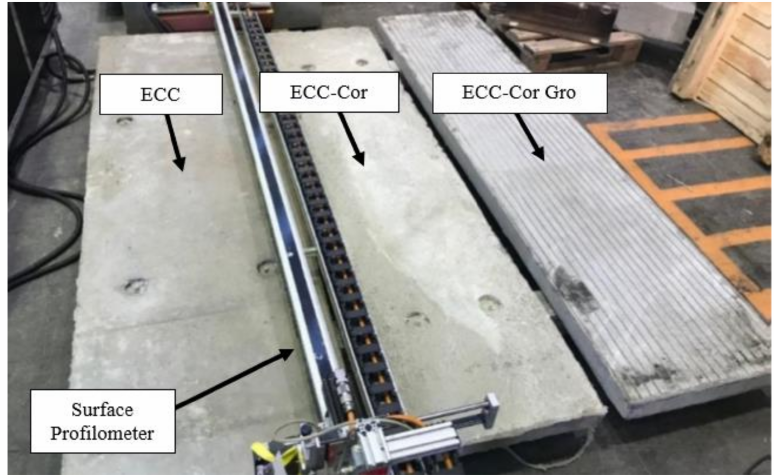
Figure 1. Specimen preparation for SHCC, modified SHCC-Cor, and SHCC-Cor-Gro (SHCC: strain- hardening cementitious composite, SHCC-Cor: Strain-hardening cementitious composites mixed with corundum aggregate, SHCC-Cor-Gro: Strain-hardening cementitious composites mixed with corundum aggregate with grooves).